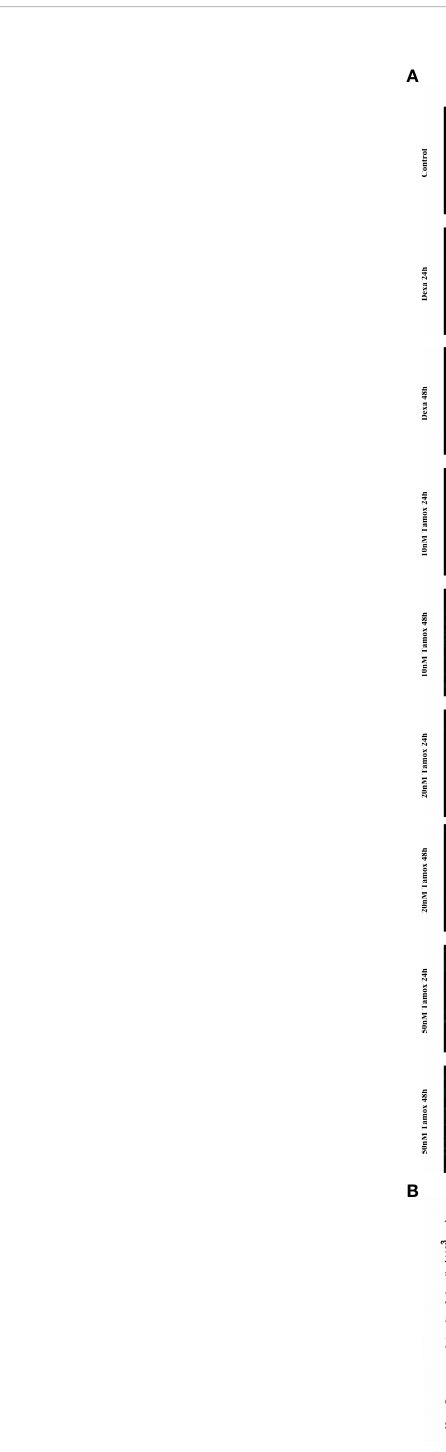
FIGURE 7 Effect of tamoxifen on vinculin expression levels. Post-detachment MCF-7 cancer cells were incubated with different concentrations of tamoxifen for 24 h and 48 h. Tamoxifen treated cells and merge plot of vinculin, F-actin and nucleus, white color scale bar 40 m m, ×40 microscope confocal lens (A) . Quantitative confocal microscopy analysis via ImageJ displays mean fl uorescence intensity. Mean values ± SD of mean immuno fl uorescence intensity of 400 cells per treatment with three independent experiments are represented re fl ecting Control, decamethastone as postitive control (D 24 h, D 48 h), 10 nM tamoxifen (10 T 24 h, 10 T 48 h), 20 nM tamoxifen (20 T 24 h, 20 T 48 h) and 50 nM tamoxifen (50 T 24 h, 50 T 48 h). Box-plot whiskers represent the 5th and 95th percentile, the median value is represented by the line within the box, and the red square box depicts the mean (B)